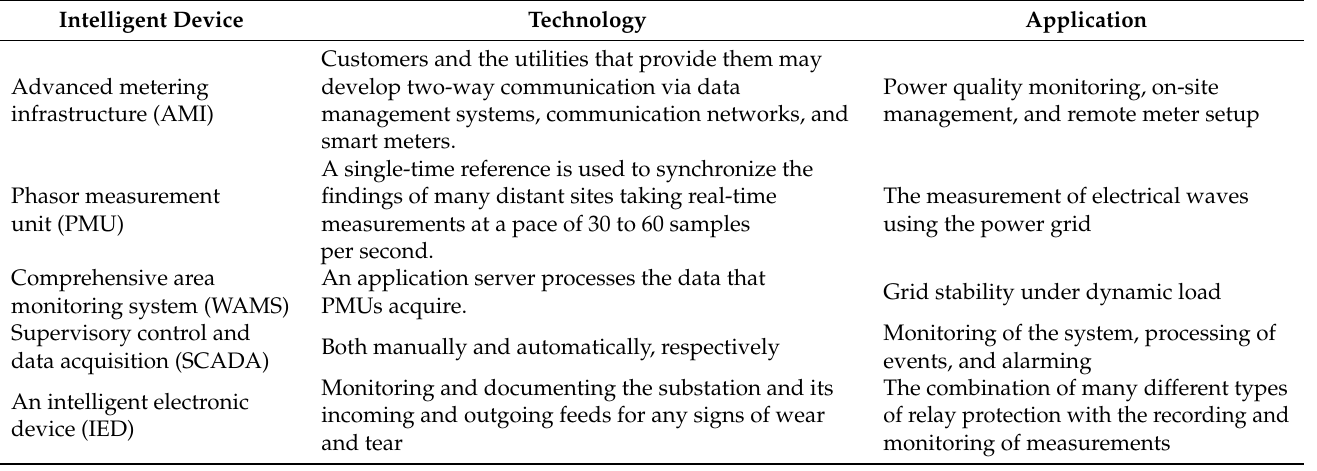
Table 2. Intelligent data collection devices and data communication techniques in SGs [37].